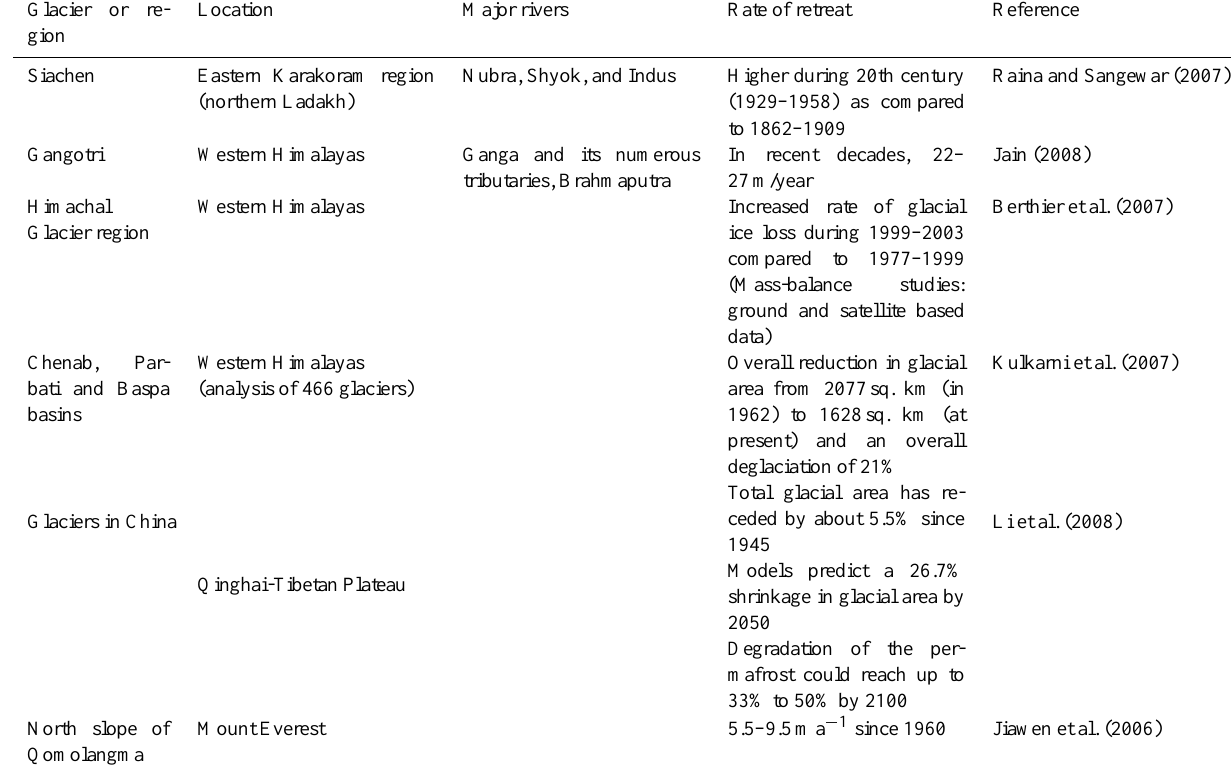
Table 1. Characteristics of the major glaciers and glacier-snow covered regions in the Himalayas and Tibetan Plateau. Glacier or